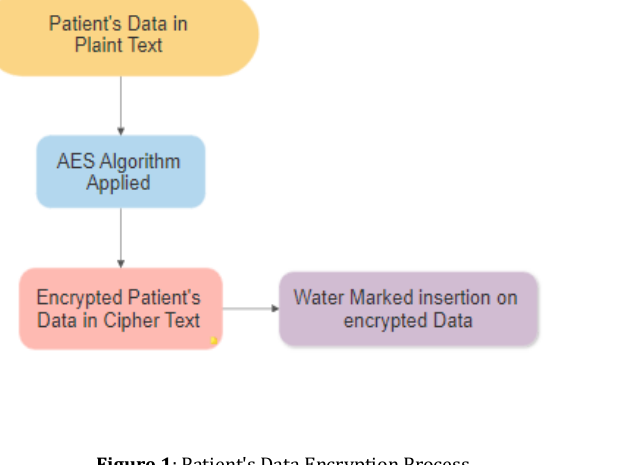
Figure 1 : Patient's Data Encryption Process